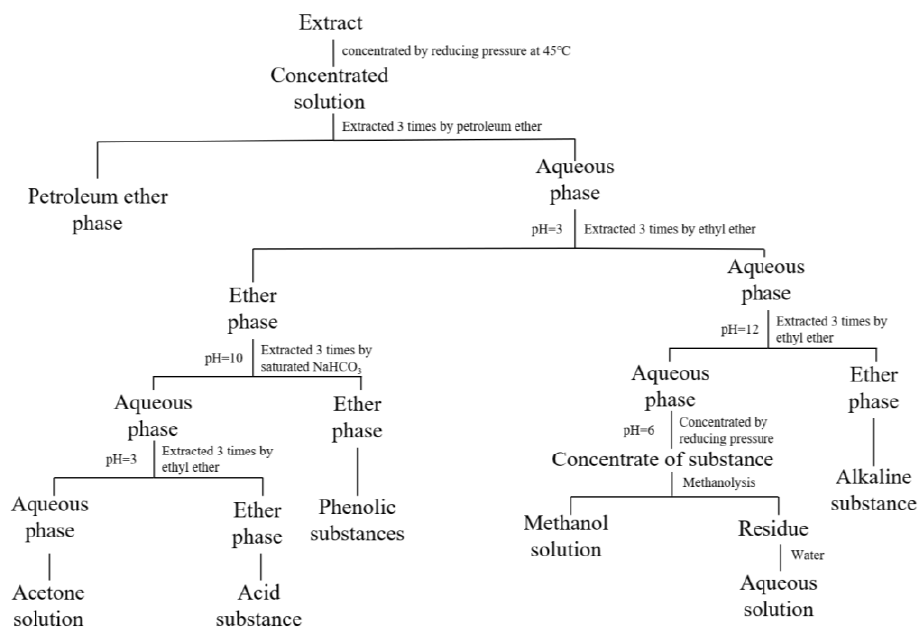
Figure 2. Separation process of seed methanol extract.